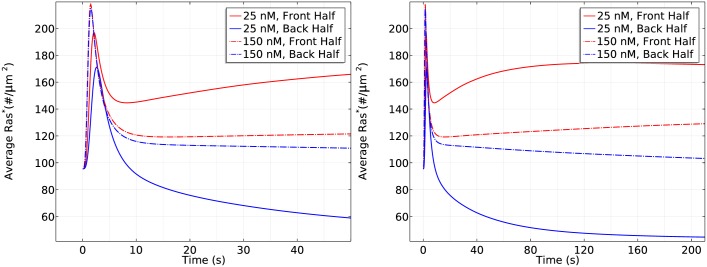
Mean concentration dependence of Ras activation.The solid lines correspond to a 5 nM = μm gradient with mean concentration 25 nM and the dash-dot lines correspond to a 5 nM = μm gradient with mean concentration 150 nM.Left: 0–50s. Right: 0–200s.